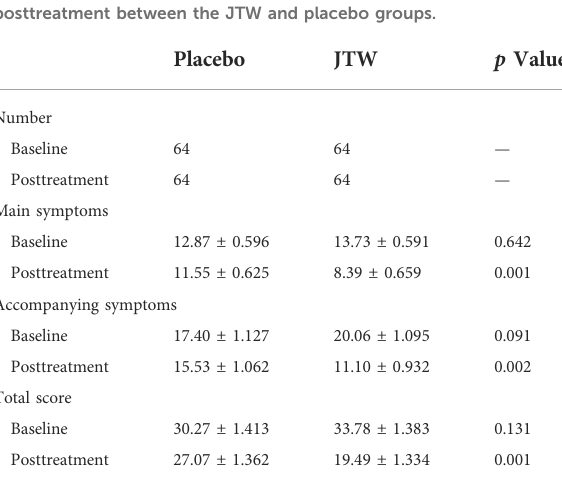
TABLE 6 Comparison of DHKSS in the participants at baseline and posttreatment between the JTW and placebo